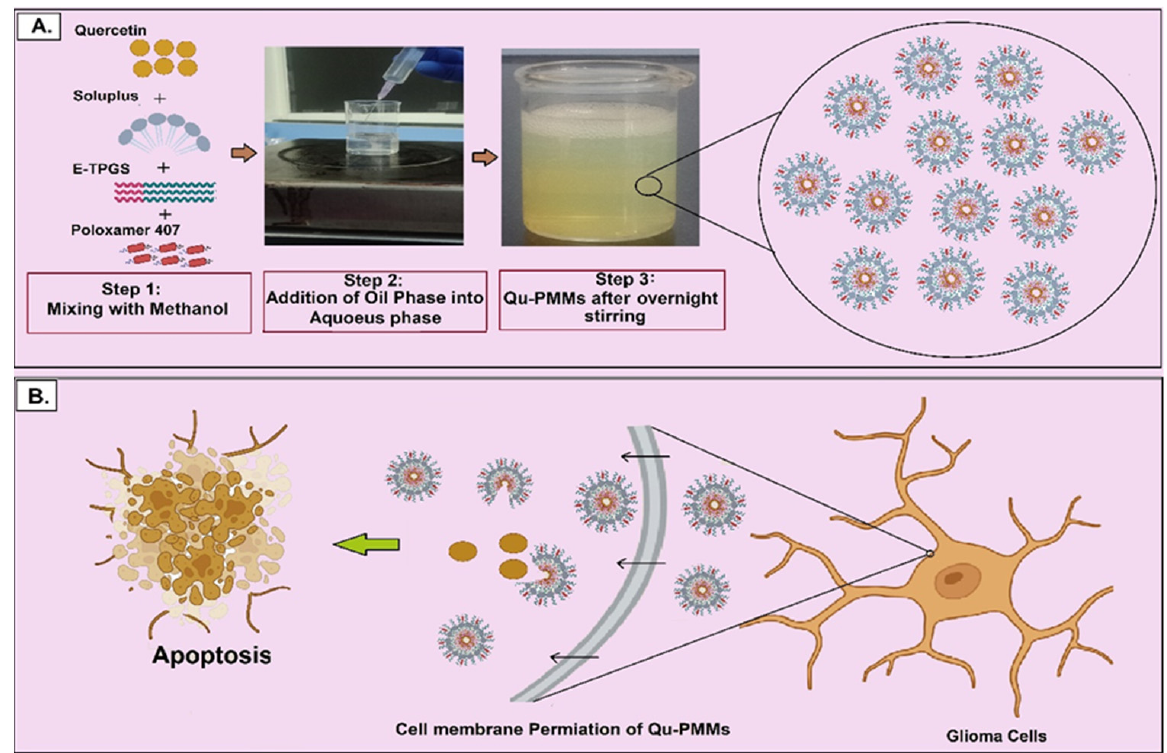
Figure 1. Schematic representation of the preparation and mode of action of polymeric mixed micelles (PMMs); ( A ) Preparation of PMMs using single emulsion solvent evaporation method; ( B ) Graphical illustration of in vitro glioma cell death on the treatment of